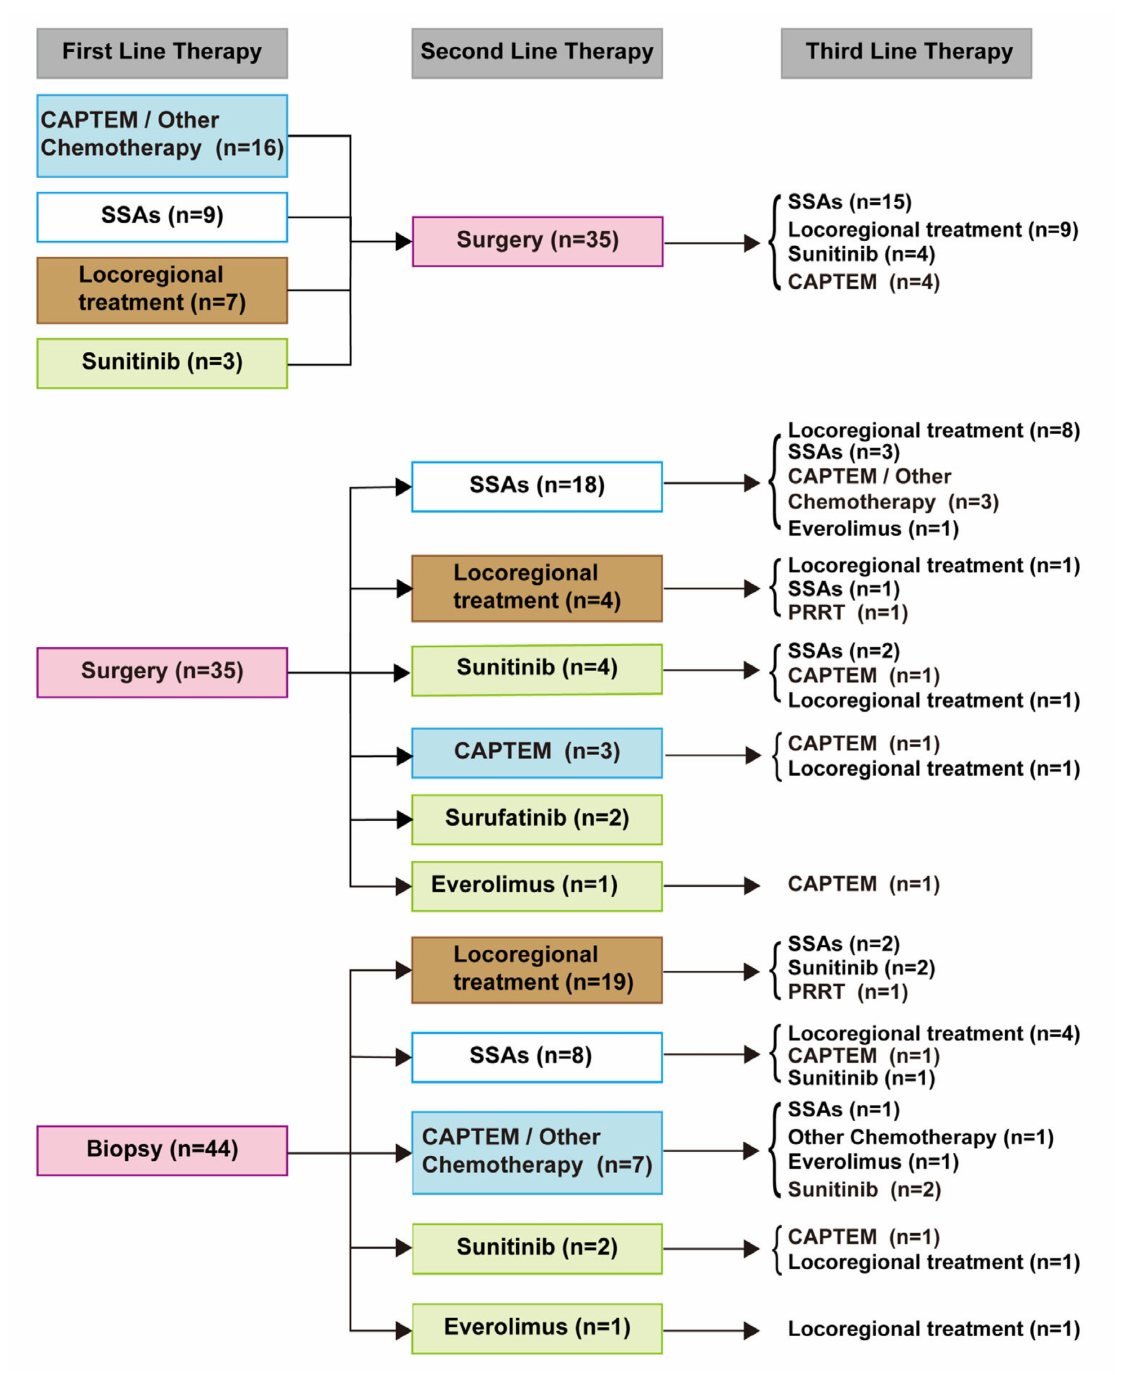
Figure 3. FUSCC treatment flowchart for patients with metastatic NF-PanNETs. A few patients received more than three lines of therapy, and some up to seven. CAPTEM: capecitabine and temo- zolomide; SSAs: somatostatin analogs; PRRT: peptide receptor radionuclide therapy.